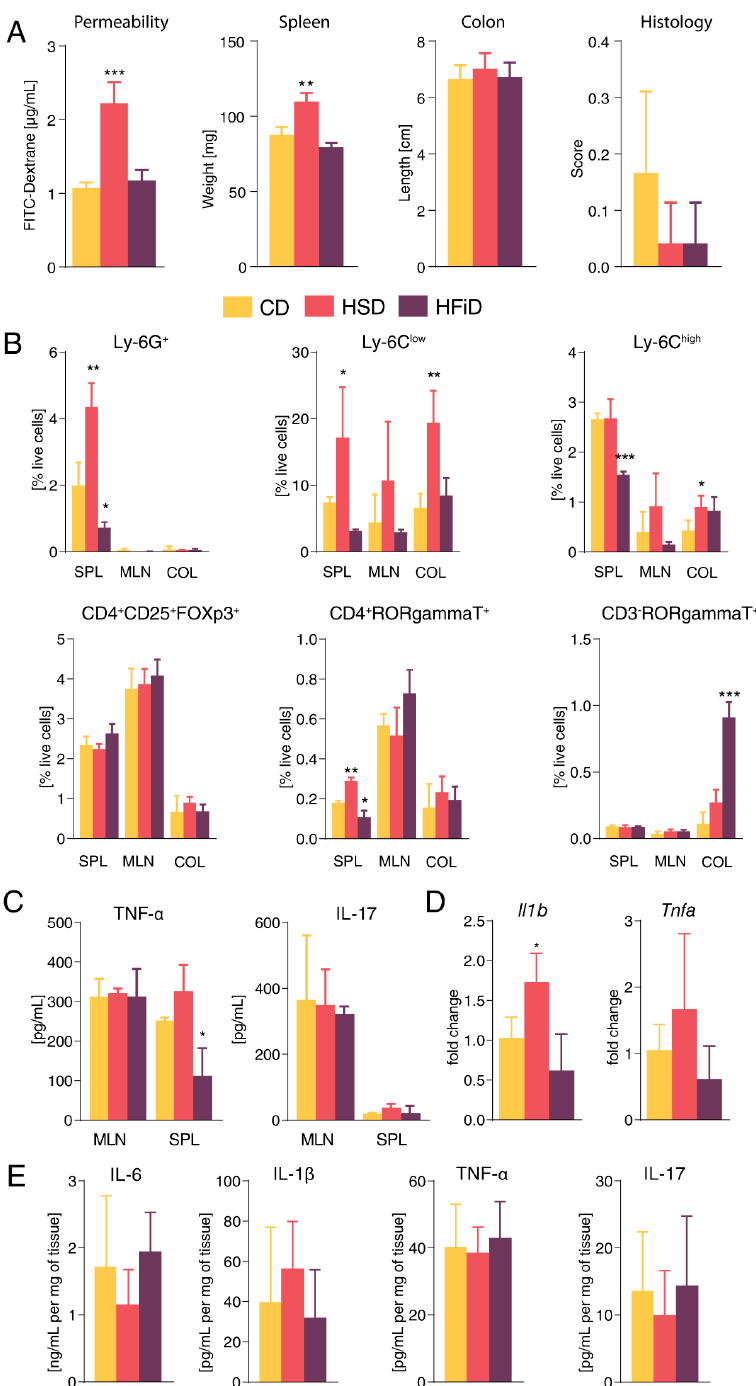
Figure 1. Diet rich in simple sugars significantly increases intestinal permeability and promotes local and systemic pro-inflammatory tuning. ( A ) Intestinal permeability, spleen weight, colon length, and histological score of mice consuming CD, HSD, and HFiD. ( B ) Percentage of live cells from spleens, mesenteric lymph nodes, and colons measured by flow cytometry. ( C ) TNF- α and IL-17 production in cell suspensions from mesenteric lymph nodes and spleens stimulated with anti-CD3 /